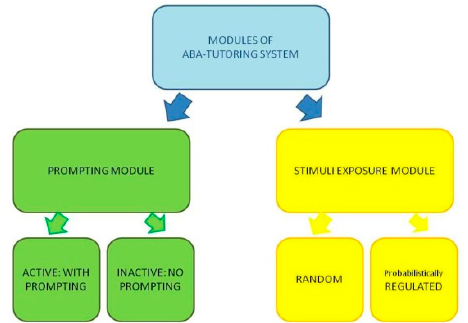
Figure 1. ABA tutor architecture with two modules.